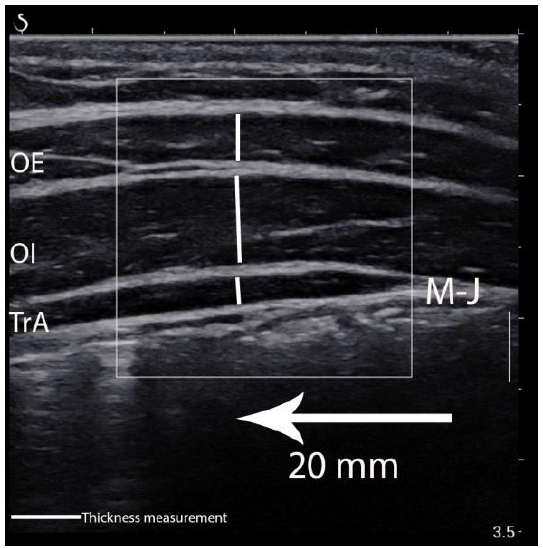
Figure 3. Thickness measurement of the lateral abdominal muscles. OE — oblique external; OI — oblique internal; TrA — transversus abdominis muscle; M-J — myofascial junction of the TrA.